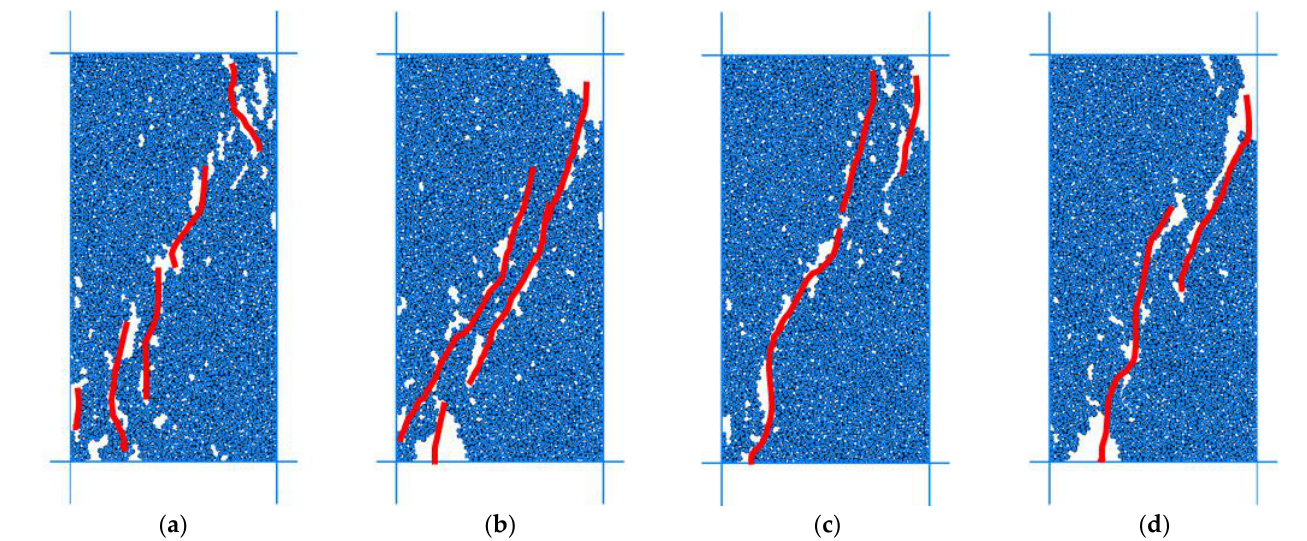
Figure 17. Comparison of biaxial test results under different confining pressures, ( a ) 1 × 10 6 Simulation results, ( b ) 10 × 10 6 simulation results, ( c ) 20 × 10 6 simulation results, ( d ) 30 × 10 6 simulation results. (As shown in the figure above, colored lines are cracks, and gray and white particles).